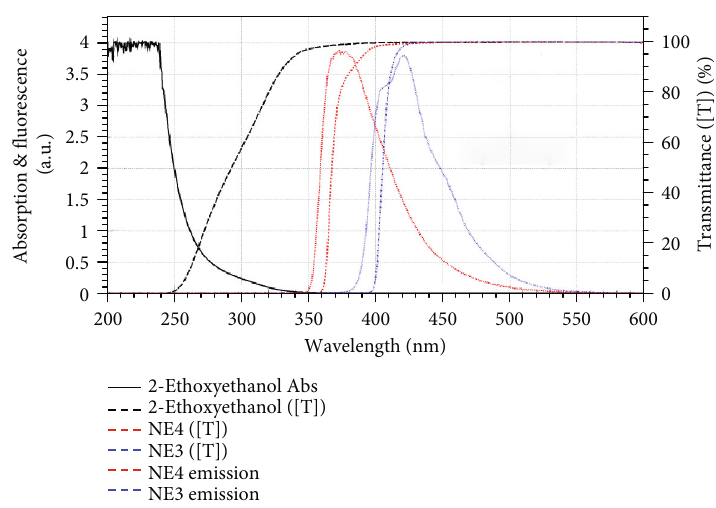
Figure 2: Absorption and emission spectrum as a function of wavelength on one plot. Based on the absorption spectra of the samples, an excitation wavelength was selected. The overlap of absorption and emission spectra in each sample group can be